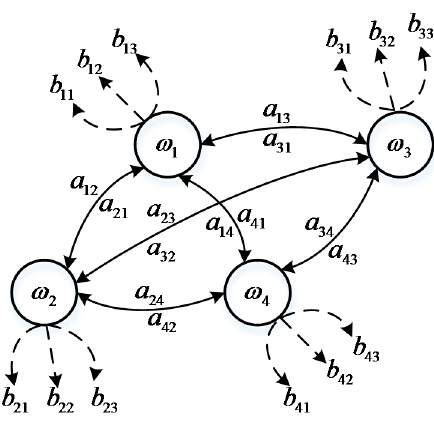
Figure 2. Finite state machine.